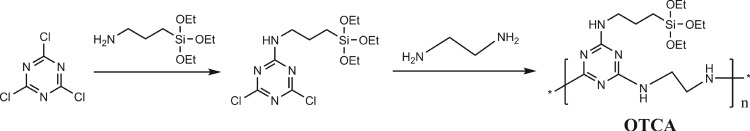
Route for the synthesis of OTCA.